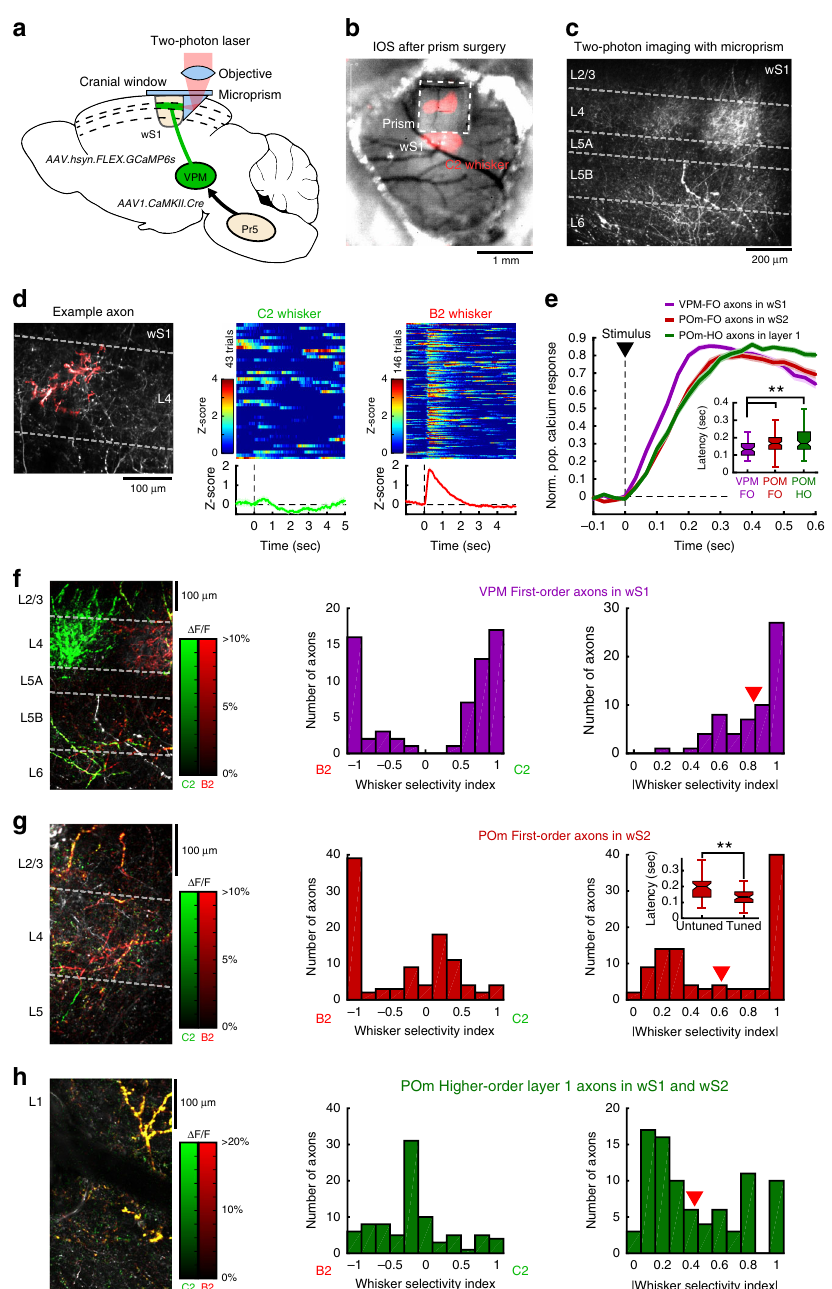
Fig. 3 Calcium imaging of thalamocortical axons during passive whisker stimulation. a Schematic of viral vector injection and microprism implantation for in vivo calcium imaging of thalamocortical axons expressing GCaMP6s. b Intrinsic optical signal in wS1 during whisker stimulation. This experiment was repeated in 14 mice with similar results. c Two-photon image of VPM axons in wS1. Similar results were observed in three mice. d Left: Example of a region of interest for axonal segments with high calcium signal correlation in wS1 (red). Right: Corresponding calcium responses to C2 or B2 whisker stimulation in z -score across trials. The average calcium responses are shown below. e Normalized calcium responses averaged over all axons for each population (3 mice, n = 62 axons for VPM-FO; 3 mice, n = 101 axons for POm-FO; 8 mice, n = 86 axons for POm-HO). Inset: Response latency comparison (Kruskal – Wallis two- sided test with Bonferroni correction, ** p = 0.008 for VPM-FO vs. POm-FO, ** p = 0.004 for VPM-FO vs. POm-HO, p = 1 for POm-FO vs. POm-HO). Boxplot: central mark indicates the median and edges indicate 25th and 75th percentiles. Whiskers extend to the largest or smallest point comprised within 1.5× of the interquartile range from both edges. f Left: Two-photon image of the calcium response ( Δ F / F ) for C2 (green) and B2 (red) whisker stimulation overlaid on top of VPM axonal innervation (gray) in wS1. Middle: Distribution of whisker selectivity indices for the corresponding axonal population (3 mice, n = 62 axons). Right: Distribution for the absolute value of the whisker selectivity index. Red arrow: average value. g Same as f , but for POm-FO axons in wS2 (3 mice, n = 101 axons). Inset in the right panel: Response latency comparison between tuned (|WSI| ⩾ 0.75) and untuned (|WSI|<0.75) axons (Kruskal – Wallis two-sided test, ** p = 0.002). Boxplot statistics same as in ( e ) inset. h Same as f , but for putative POm-HO axons located in layer 1 (8 mice, n = 86 axons). Kruskal – Wallis test with Bonferroni correction comparing |WSI|: p = 0.003 for VPM-FO vs. POm-FO; p = 4×10 − 11 for VPM-FO vs. POm-HO; and p = 4×10 − 11 for POm-FO vs.